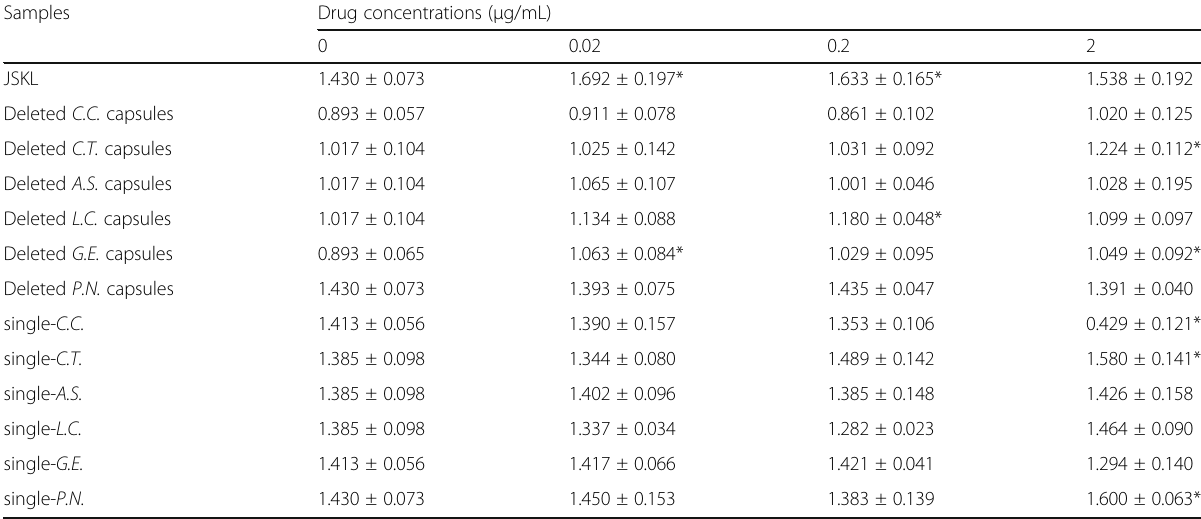
Table 2 Effects of different drug concentrations of JSKL, deleted-herb-capsule and single-herb-capsule on MH7A cells activity Samples